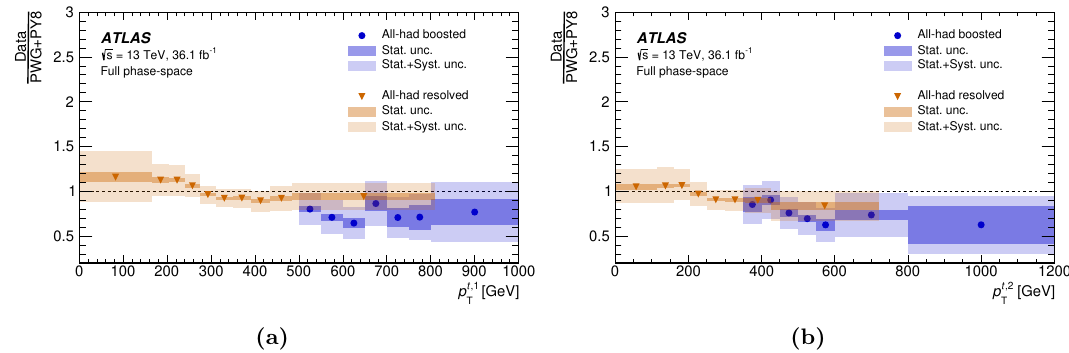
Figure 24 . The ratios of the measured absolute differential cross-sections at parton level to the predictions obtained with the Powheg+Pythia 8 MC generator in the all-hadronic resolved and boosted topologies as a function of the (a) p t, 1 and (b) p t, 2 T T